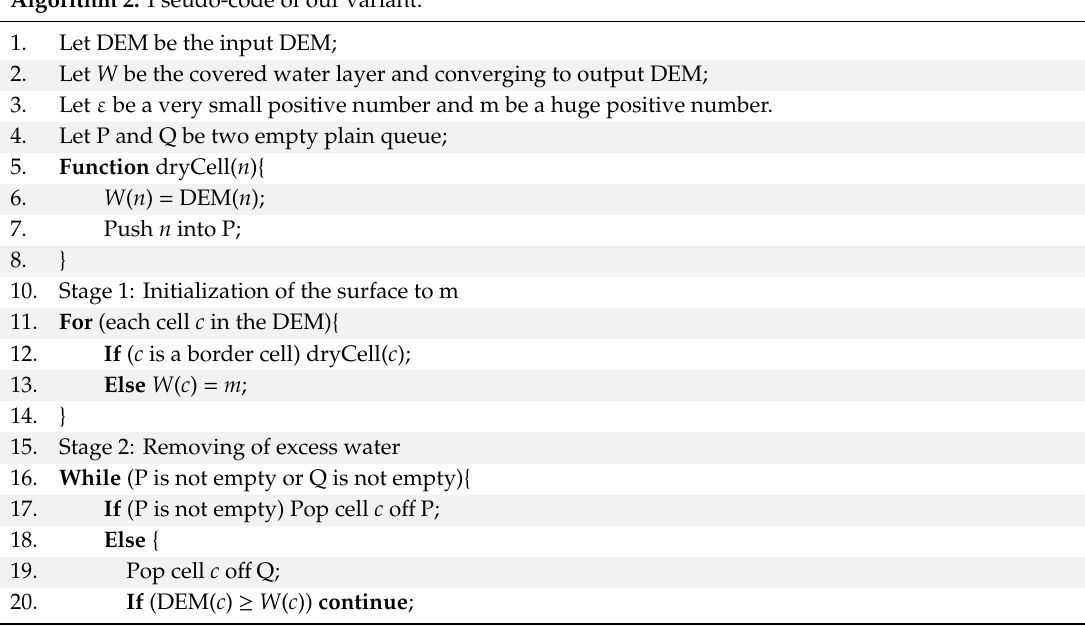
Algorithm 2. Pseudo-code of our